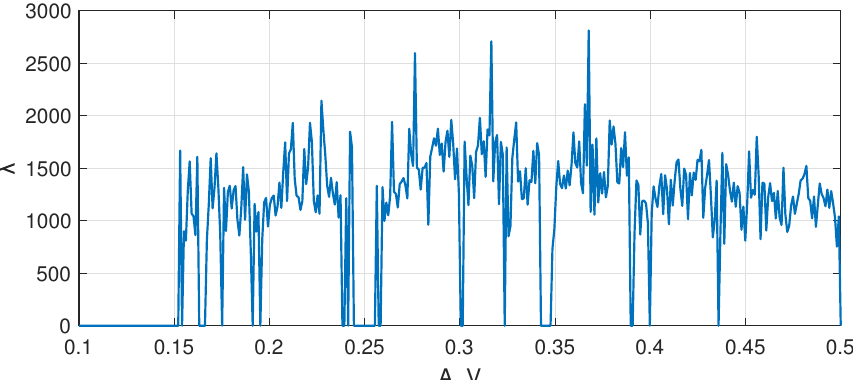
Figure 12. Dependence of the largest Lyapunov exponent (LLE) on the input sine wave amplitude.